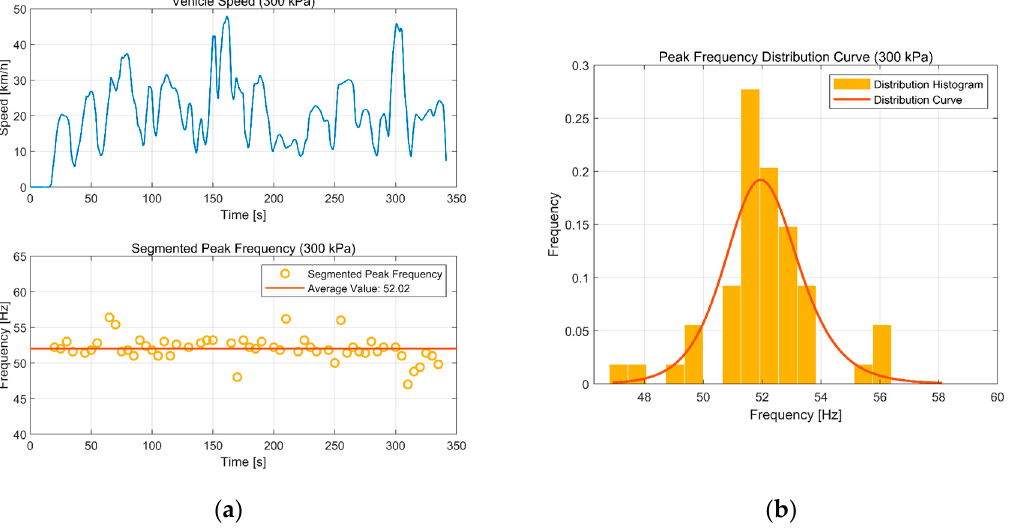
Figure 13. Result at 300 kPa: ( a ) Peak-frequency extraction; ( b ) peak frequency distribution curve.